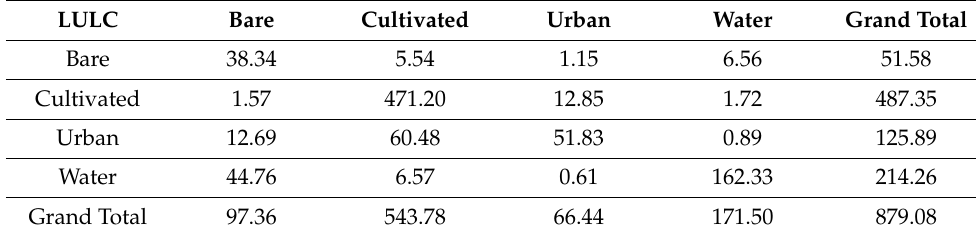
Table 6. Transition of LU/LC (km 2 ) from 2001–2011.